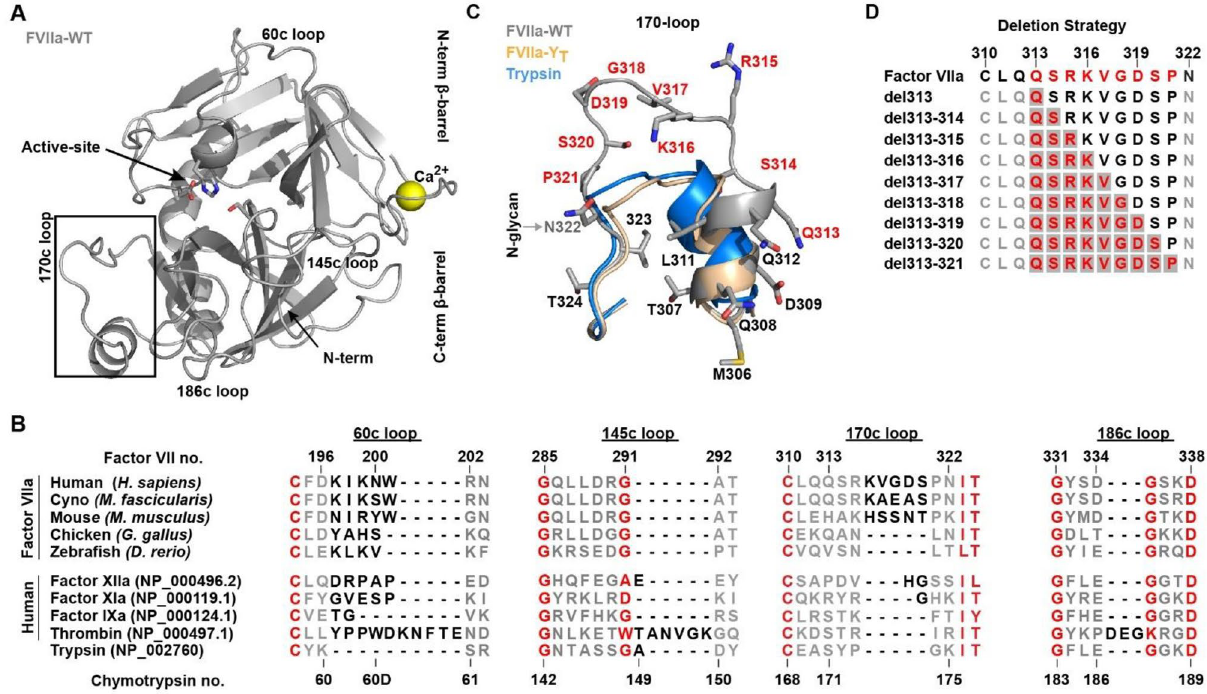
Figure 1. FVII Structural Features and the Evolution of Surface-Exposed Loops. ( A ) Crystal structure of FVIIa:sTF (PDB ID:1dan, grey 21 ), shown in standard representation. ( B ) Alignment of serine proteases from various stages of blood coagulation compared with the ancestral protease trypsin, together with the surface- exposed loops of FVIIa from various species (see supplemental Fig. S1). Conserved residues are shown in red, non-conserved in grey and the loop extension region in black. Both numbering based on the human Factor VII sequence and on the consensus Chymotrypsin numbering is shown. ( C ) The different conformations of the 170 loop in FVIIa, FVIIa-Y T (4z6a, wheat 25 ) and trypsin (3ptn, blue 74 ) with deletion scanned residues in red and an N-glycan attachment site. ( D ) Deletion strategy in FVIIa with scanned residues in red and start positions for each deletion window marked with grey. A total of 39 variants were generated by moving the deletion windows through the